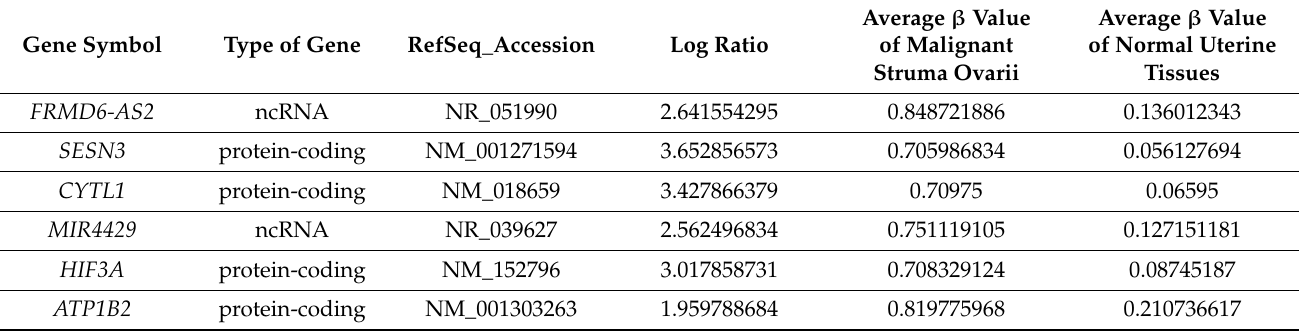
Table 2. The DNA methylation analysis detected the methylation of FRMD6-AS2 , SESN3 , CYTL1 , MIR4429 , HIF3A , and ATP1B2 in malignant struma